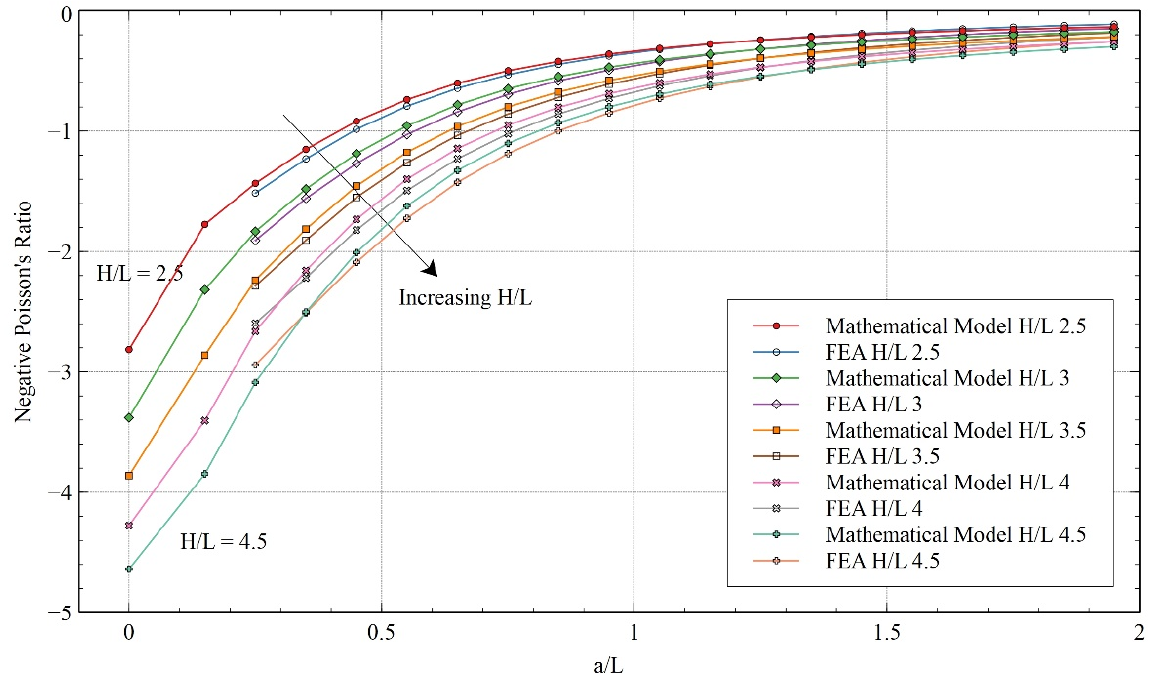
Figure 15. Comparison of Poisson’s ratio obtained from the FEA and mathematical model for varying H/L for y-direction loading.